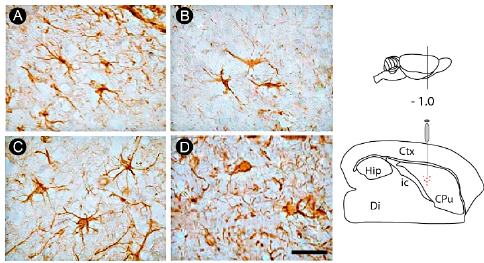
Figure 5. Astrocytosis in the internal capsule following endothelin − 1 (ET − 1) striatal injection. Non- activated astrocytes are observed in control group ( A ). A progressive astrocytosis is seen at 1PLD ( B ) and 3PLD ( C ), with hypertrophic cell bodies and short and thick processes being observed at 7PLD ( D ). Drawings at the left side of the figure show the anatomical localization of the ET − 1 injection in the striatum. Ctx: cortex; CPu: caudate putamen (striatum); Di: diencephalon; Hip: hippocampus; ic: internal capsule. Scale bar: 50 μ m.